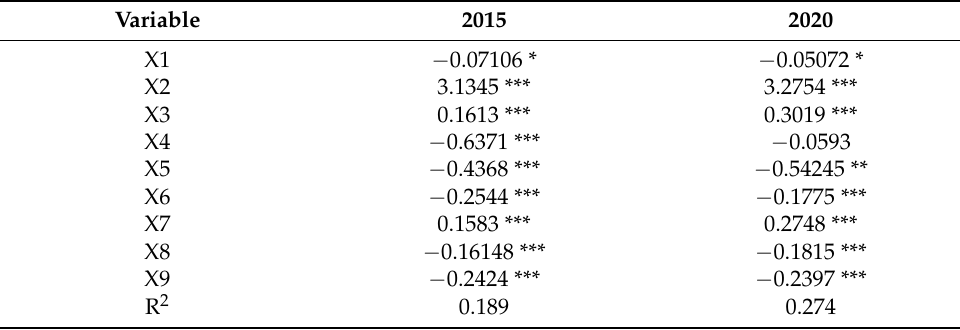
Table 4. Regression results of industrial overall location